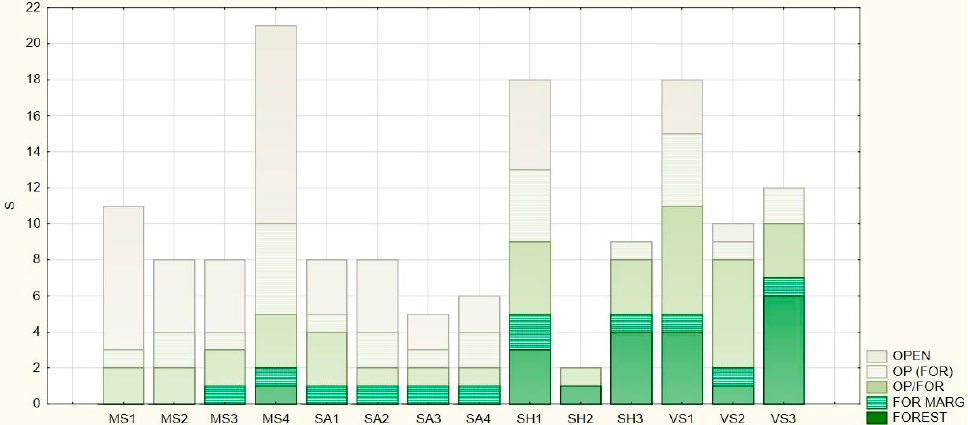
Figure 4. Distribution of herbaceous species by forest affinity